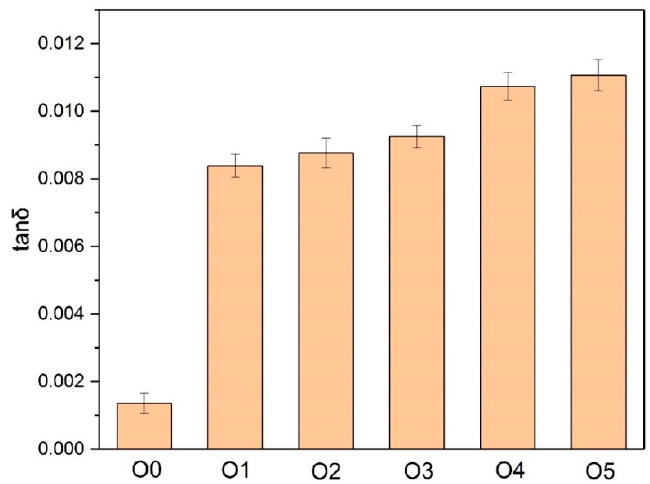
Figure 5. The influence of the different amine compounds on the dielectric loss of oil.